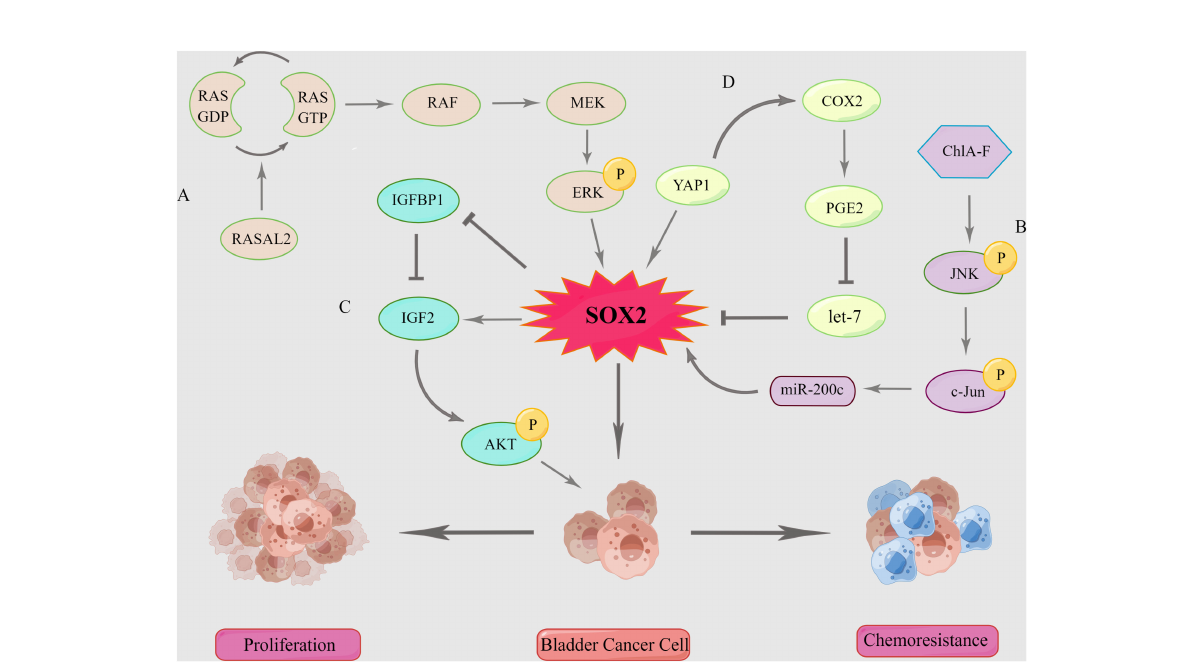
FIGURE 3 SOX2-related signaling pathway in bladder cancer. (A) MAPK/ERK signaling pathway. (B) MAPK/JNK signaling pathway. (C) SOX2-IGF2-AKT signaling pathway. (D) COX2/PGE2 Axis and YAP1-SOX2 signaling pathway. “ P ” stands for phosphorylation. By